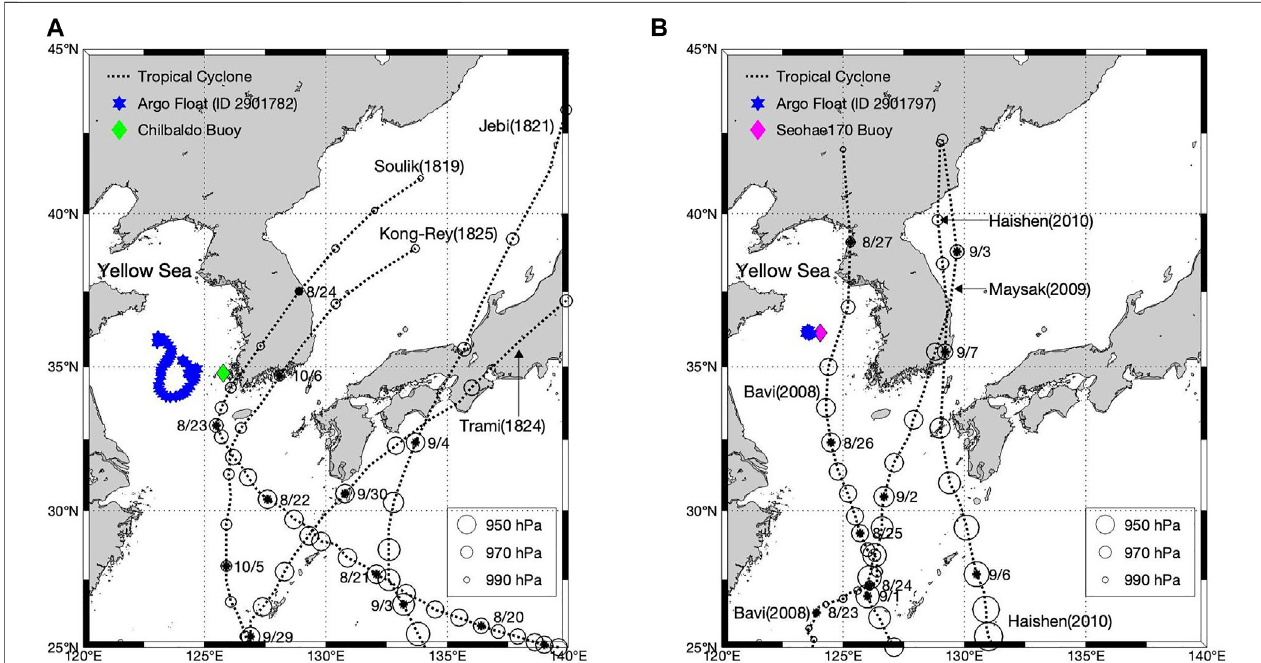
FIGURE1| Locationmapoftheoceanbuoys,Argo fl oattracks,andtracksofeachtropicalcyclonearoundtheKoreanPeninsulain (A) August – October2018,and (B) August – September 2020.